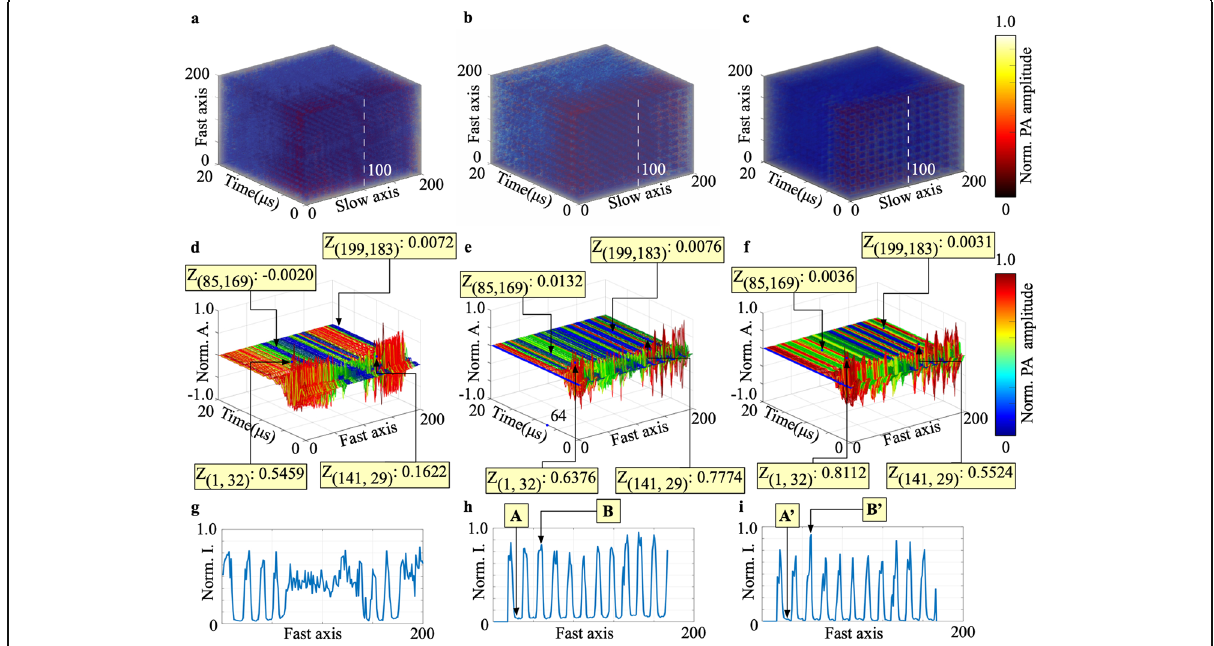
Fig. 4 Analysis of using SWM to process a resolution chart. a : Original 3D image; b : The result of denoising and registration of Fig. a ; c : 3D deconvolution result of Fig. b ; d - f : A-lines stack of white dashed line in Figs. a - c , respectively; g - i : The profiles of MAP images of Figs. a - c marked with the white dashed line. Norm.: Normalized; A., Amplitude; I.: